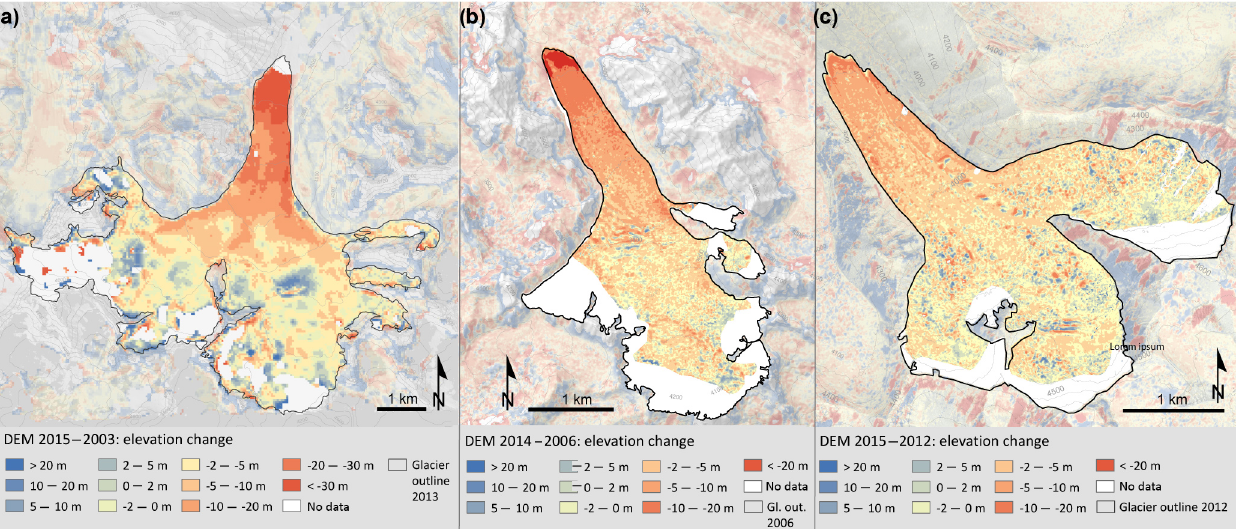
Figure 10. Geodetic mass balance for (a) Abramov from 2003 to 2015, (b) Golubin from 2006 to 2014 and for (c) Glacier no. 354 from 2012 to 2015.